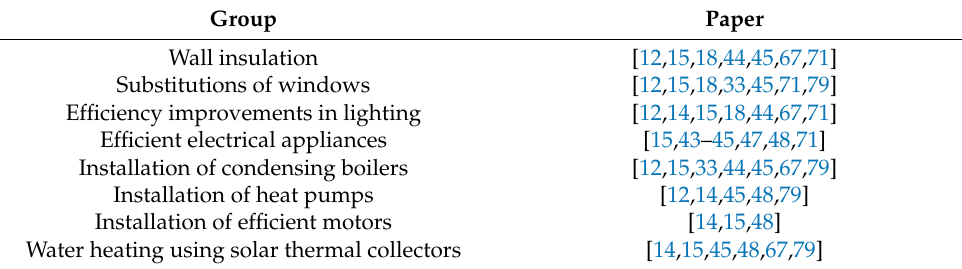
Table 3. Papers that point out measures that reduce emissions. Group